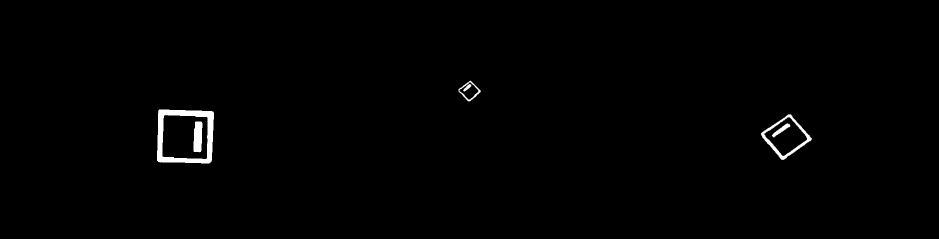
Figure 8. Samples from the thermal dataset.